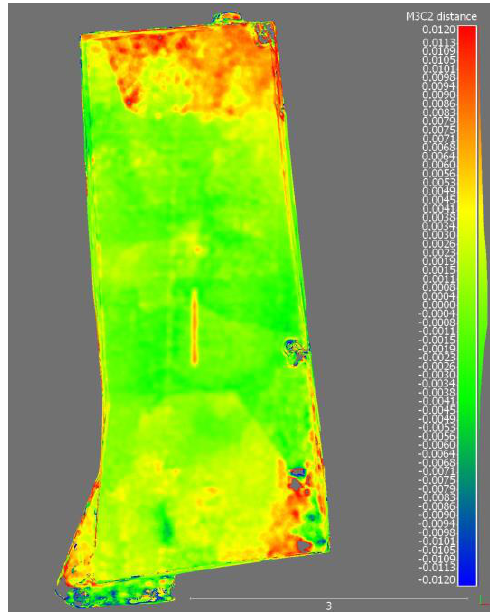
Figure 11. Colour map of the distance (m) between the models on the floor